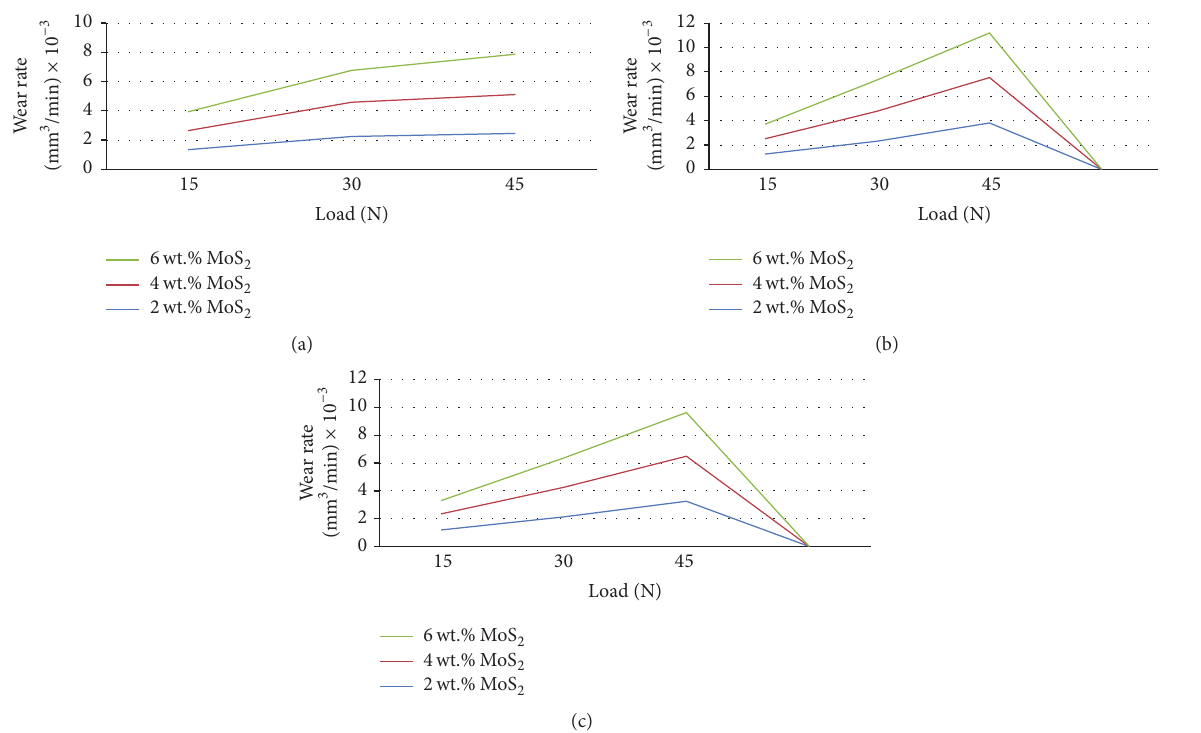
Figure 2: (a) Wear rate of Al6061/12 wt.% Al 2 O 3 /MoS 2 during sliding velocity of 1.25 m/sec. (b) Wear rate of Al6061/12wt.% Al 2 O 3 /MoS 2 during sliding velocity of 2.50 m/sec. (c) Wear rate of Al6061/12 wt.% Al 2 O 3 /MoS 2 during sliding velocity of 3.25 m/sec.